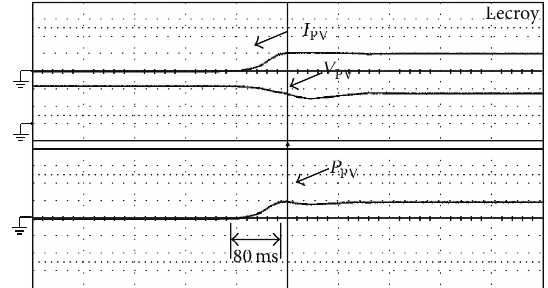
, current 𝐼 , and power 𝑃 wave- PV PV PV = 750 W. PV ( max )